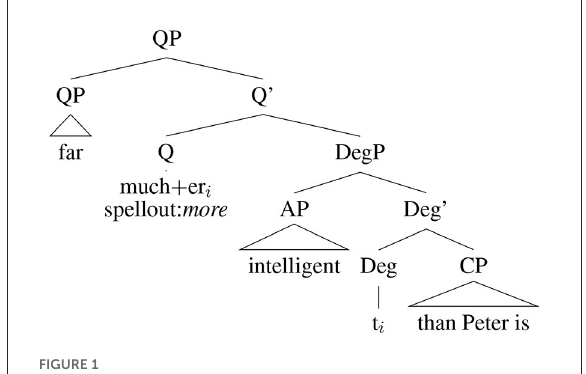
FIGURE1 Comparative structure after